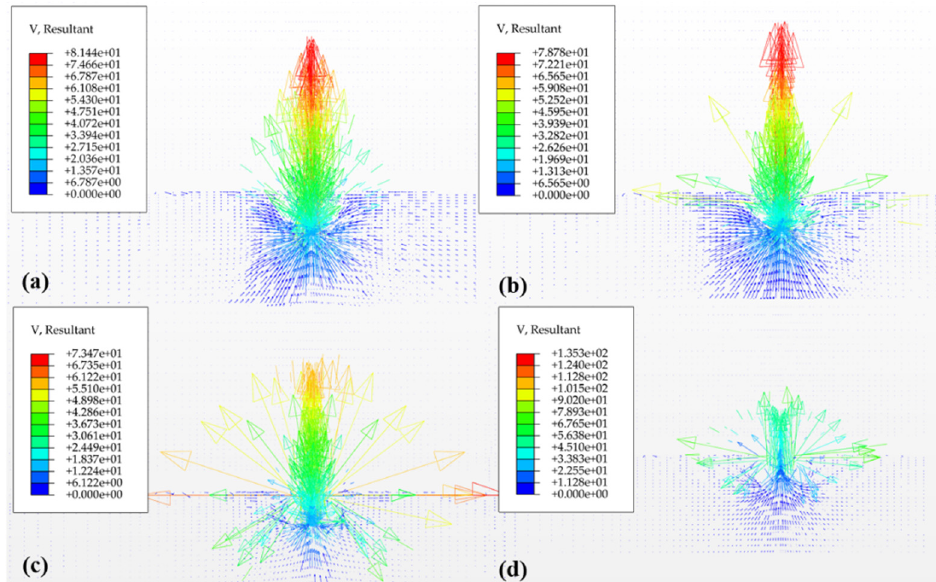
Figure 21. Velocity field in the bubble area during the collapse phase at: ( a ) t = 6.45 ms; ( b ) t = 6.55 ms; ( c ) t = 6.70 ms; and ( d ) t = 6.95 ms.